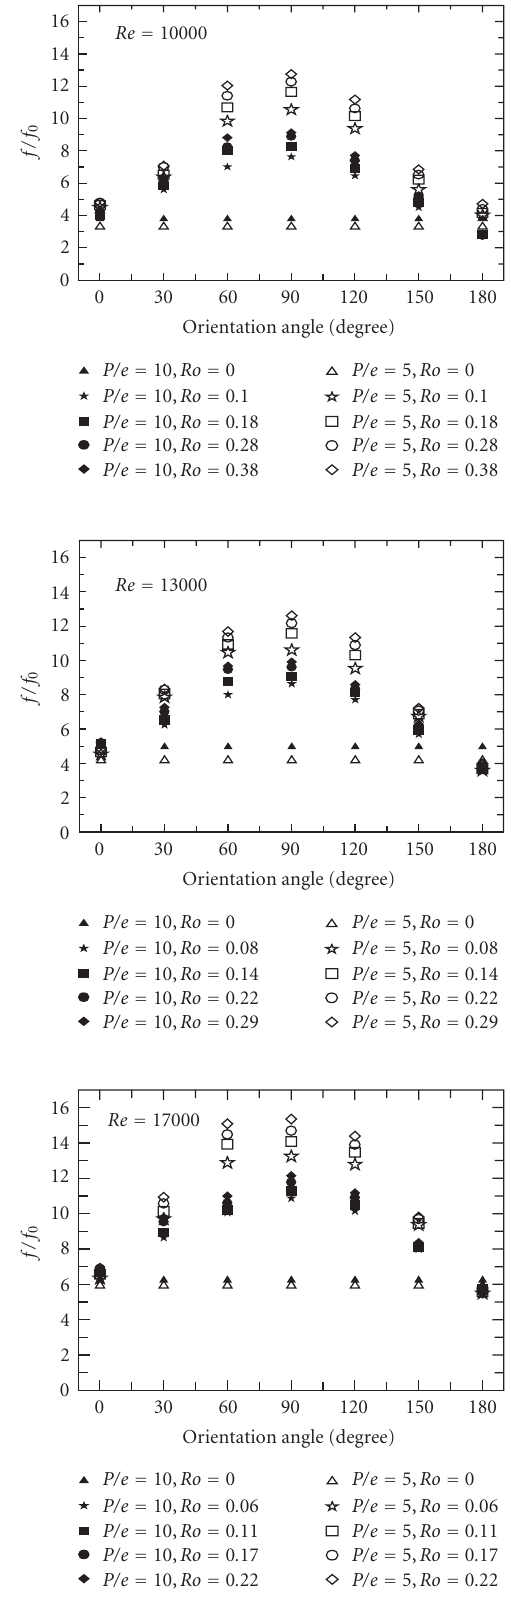
Figure 4: E ff ect of orientation angle in a rib-roughened square channel with detached ribs on one